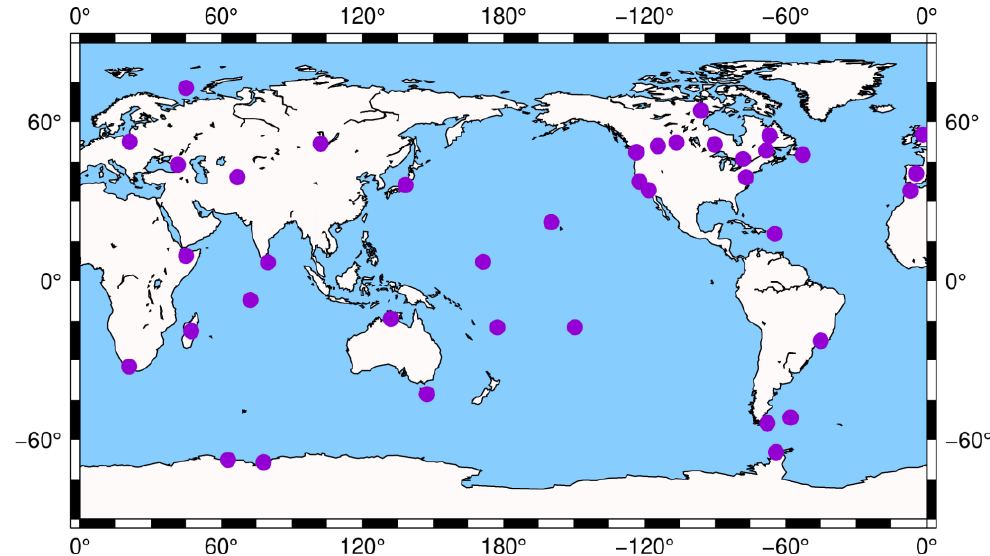
Figure 2. One example of station selection with 40 stations for satellite clock batch estimation. The purple circles represent selected stations.